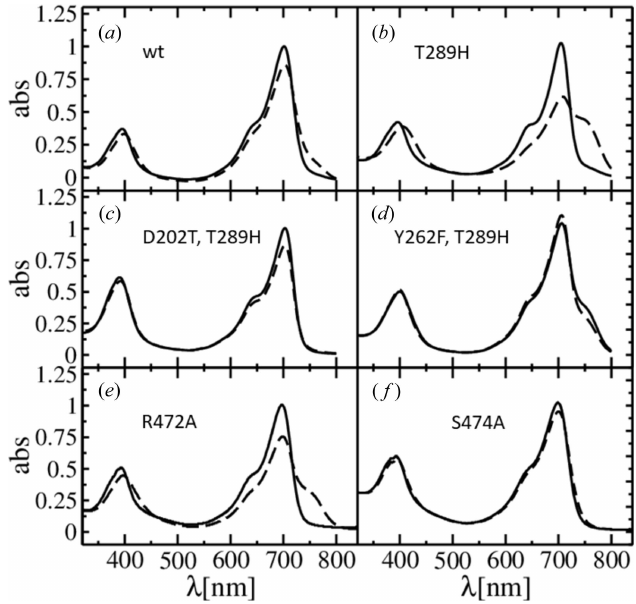
Figure 4 Absorption spectra of various SaBphP1 PCM constructs where the Pr to Pfr transition is initiated with 700 nm light. Black solid line, 20 min of 740 nm; dashed line, 20 min of 700 nm illumination; except ( d ) where illumination is for an hour. The location of the residues can best be identified in, and their function inferred from Figs. 6 and 9. ( a ) wild-type, ( b ) T289H mutant, ( c ) D208T, T289H double mutant, ( d ) Y262F, T289H double mutant. Black solid line, dark adapted and 1 h of 700 nm illumination is identical; dashed line, 1 h of 750 nm illumination, ( e ) R472A mutant, ( f ) S747A mutant.